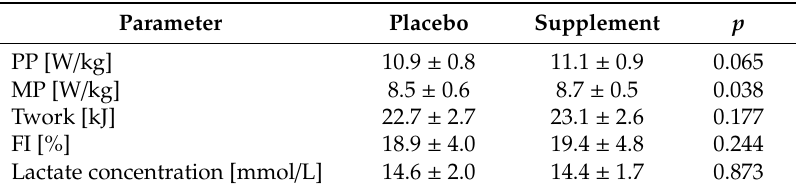
Table 2. Mean mechanical and physiological variables obtained during Wingate test. PP—peak power, MP—mean power, Twork—total work, FI—fatigue index. Significant di ff erence compared to placebo was observed for MP ( p =